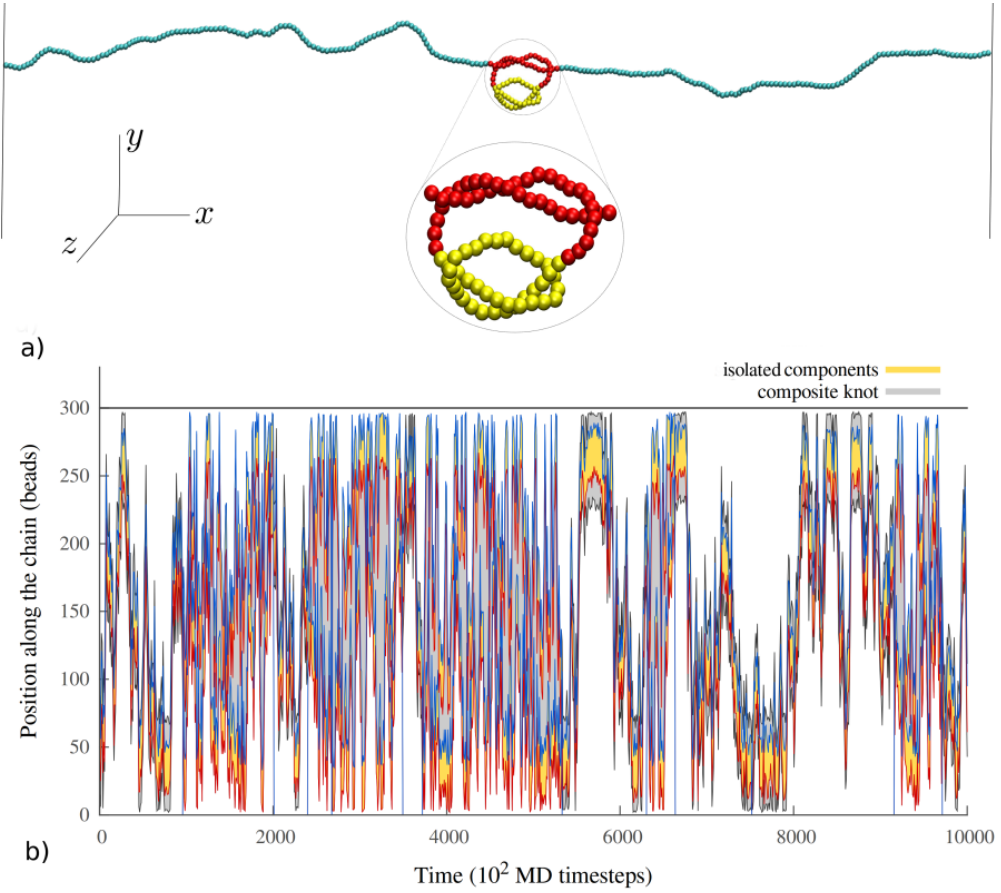
Figure 1. ( a ) An example of a configuration for the ( ++ ) system, with both knots intertwined. In this configuration, only one prime component(marked in yellow) is identified as “isolated” by our knot identification scheme based on the Minimally Interfering Closure [41]; ( b ) A small portion of an MD trajectory for the ( ++ ) system. Yellow shaded regions indicate the portions of the chain occupied by the isolated prime knots, and red and blue lines indicate their first and last bead, respectively. The portion of the chain taken up by the whole composite knot is reported as a gray shaded area. When the knots are intertwined, our algorithm identifies only one isolated knot, which can be seen in the trajectory as a single yellow region surrounded by gray boundaries. Note that the intertwined composite knot can still travel from one side of the chain to the